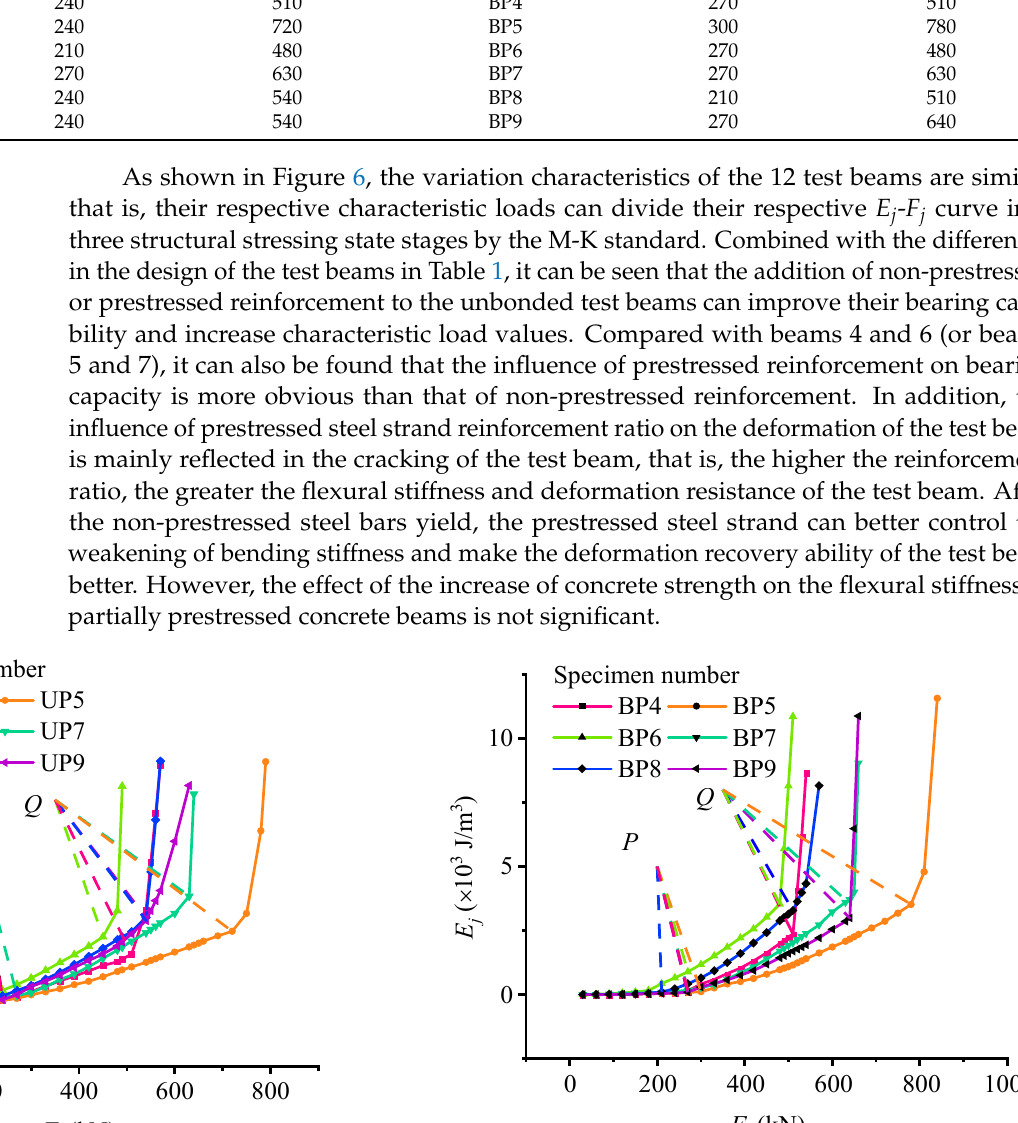
Table 5. Characteristic loads of test beams.